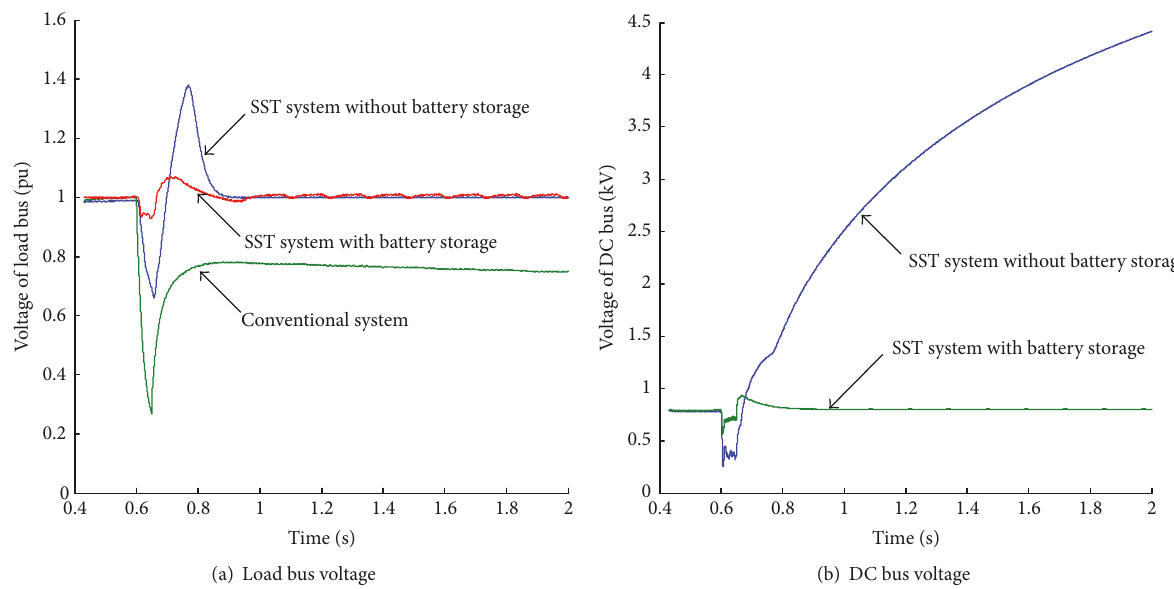
Figure 6: Response curves when three-phase short circuit fault occurs at the midpoint of Line 1.